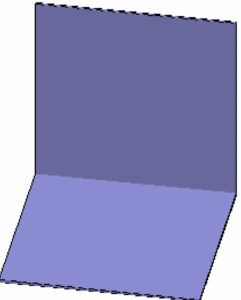
Figure 1. The dihedral angle model.